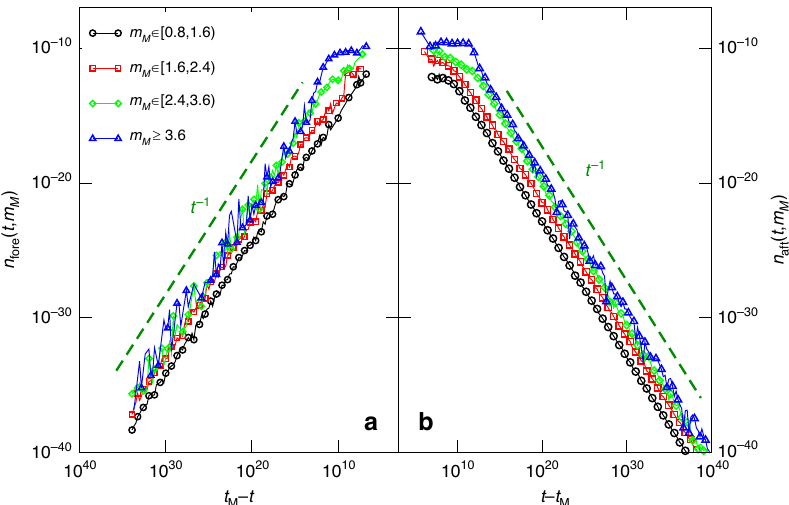
ð t ; m Þ ( a ) as function of the time M fore